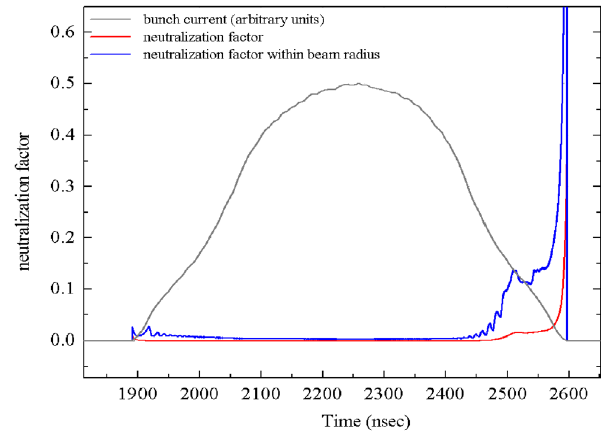
FIG. 12. (Color) Simulated electron neutralization factor in a SNS field-free region. The fractional charge neutralization computed within the beam radius region is (cid:12) 1% during the bunch passage, and it exceeds 10% at the tail of the bunch.